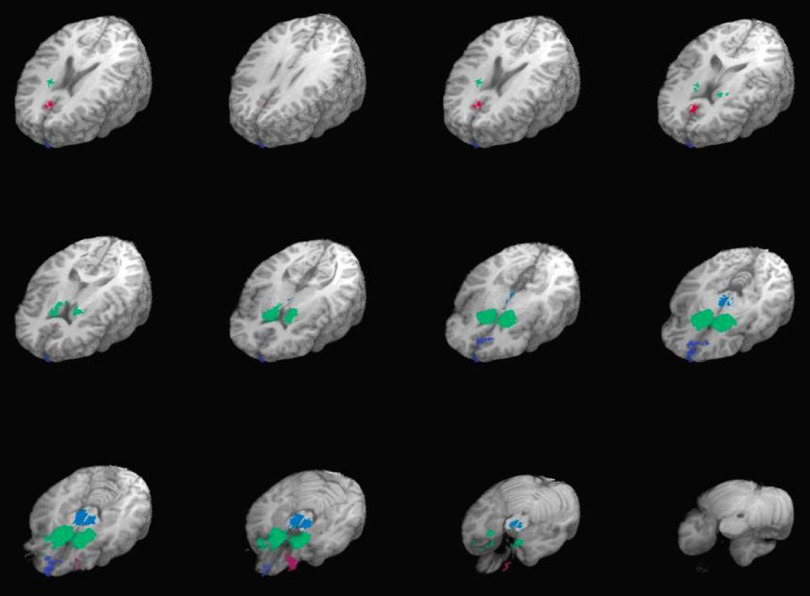
A priori defined regions of interest associated with reward-processing.
Note: Brain regions associated with “reward” in Neurosynth Meta-analysis; Talairach Z-plane coordinates = +25 to −30 in 5-mm slices; thresholded to false discovery rate q = .05.